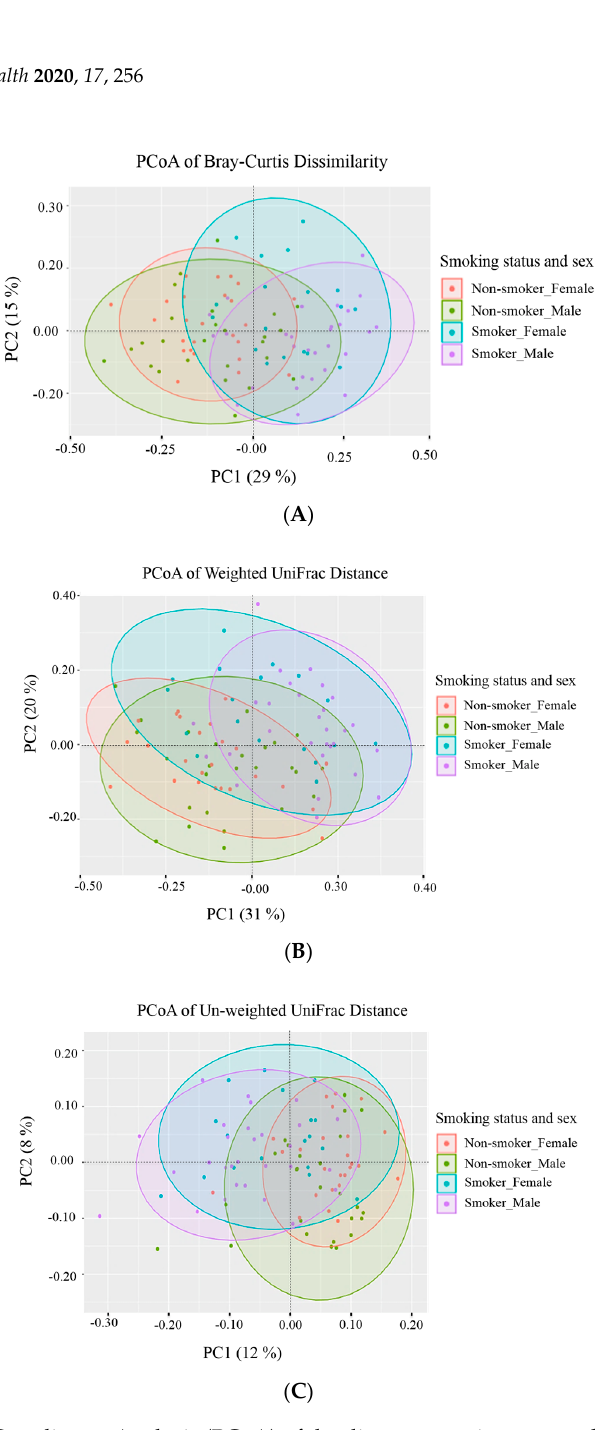
Figure 3. Principal Coordinates Analysis (PCoA) of the distance matrix generated using three distance metrics: ( A ) Bray-Curtis dissimilarity data, ( B ) Weighted UniFrac, and ( C ) Unweighted UniFrac. The x and y axes correspond to the first and second major principal coordinates (PC1 and PC2) identified from the PCoA analysis. Each principal coordinate explains a certain fraction of the variability (indicated by the percentage between brackets on each axis) observed in the data set. The principal coordinates PC1 and PC2 are plotted to create a visual two-dimensional (2D) representation of the multidimensional microbial community compositional differences between tested samples. Each sample is represented by a point and colored based on the smoking status and the sex of tested human subjects: Female non-smokers (red), male non-smokers (green), female smokers (teal green), and male smokers (magenta). The distance between the points represents the similarity of those samples (closer together = more similar).